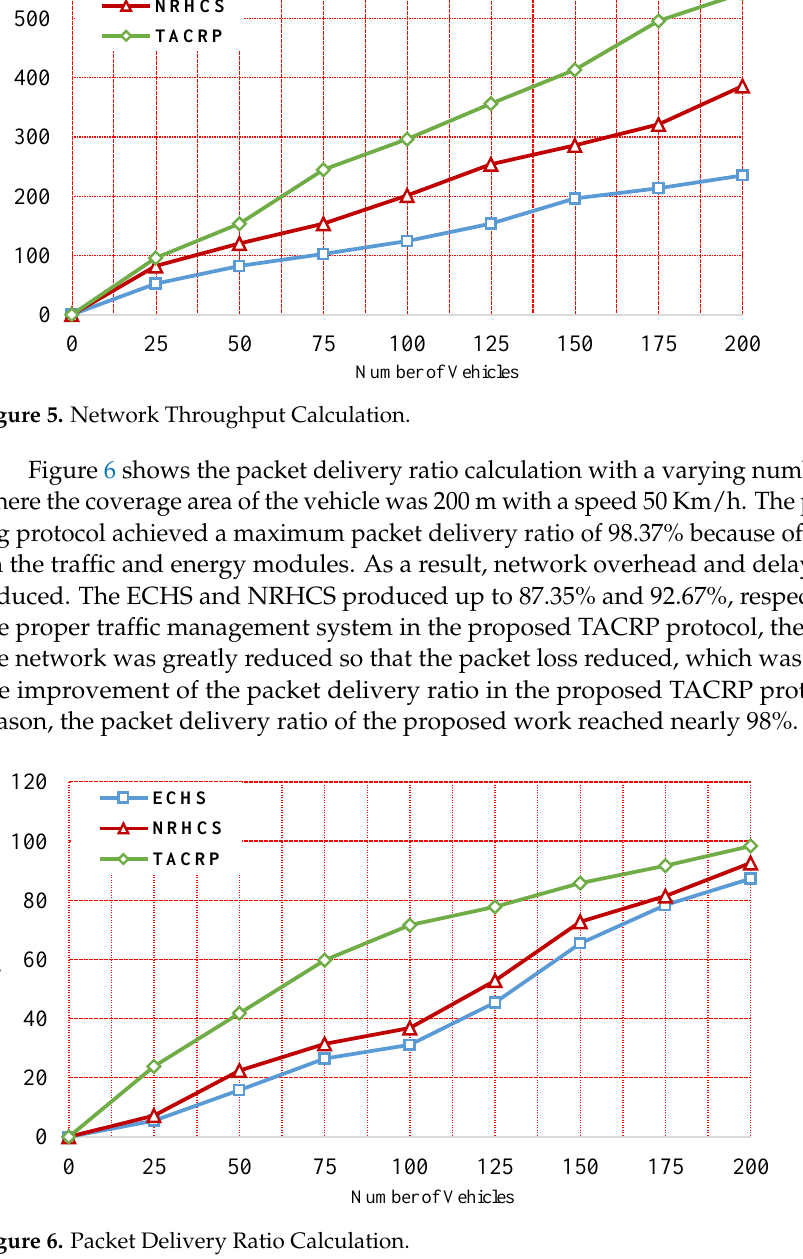
Figure 6. Packet Delivery Ratio Calculation.